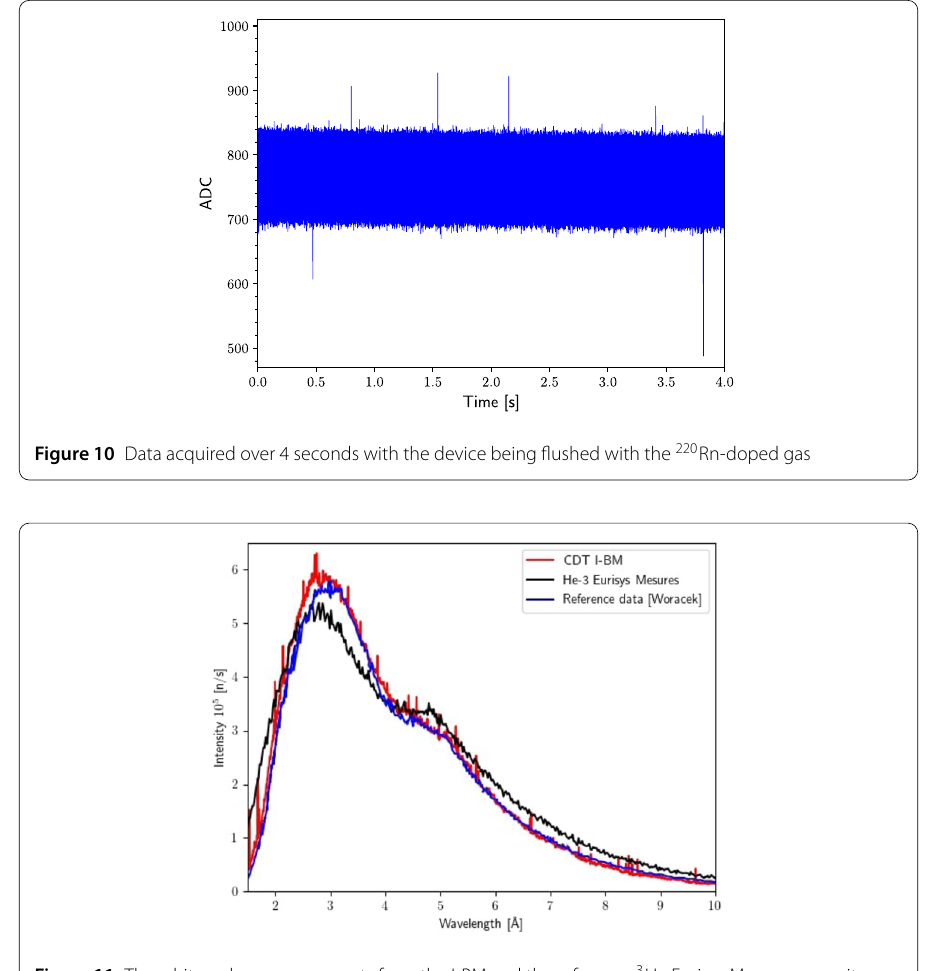
Figure 11 The white pulse measurements from the I-BM and the reference 3 He Eurisys Measures monitor